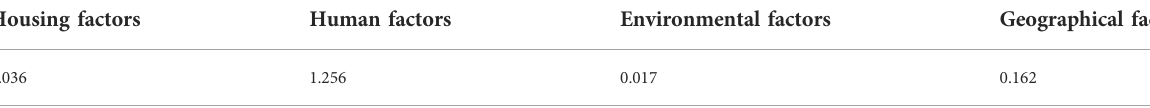
TABLE 12 The emotional characteristics of the element